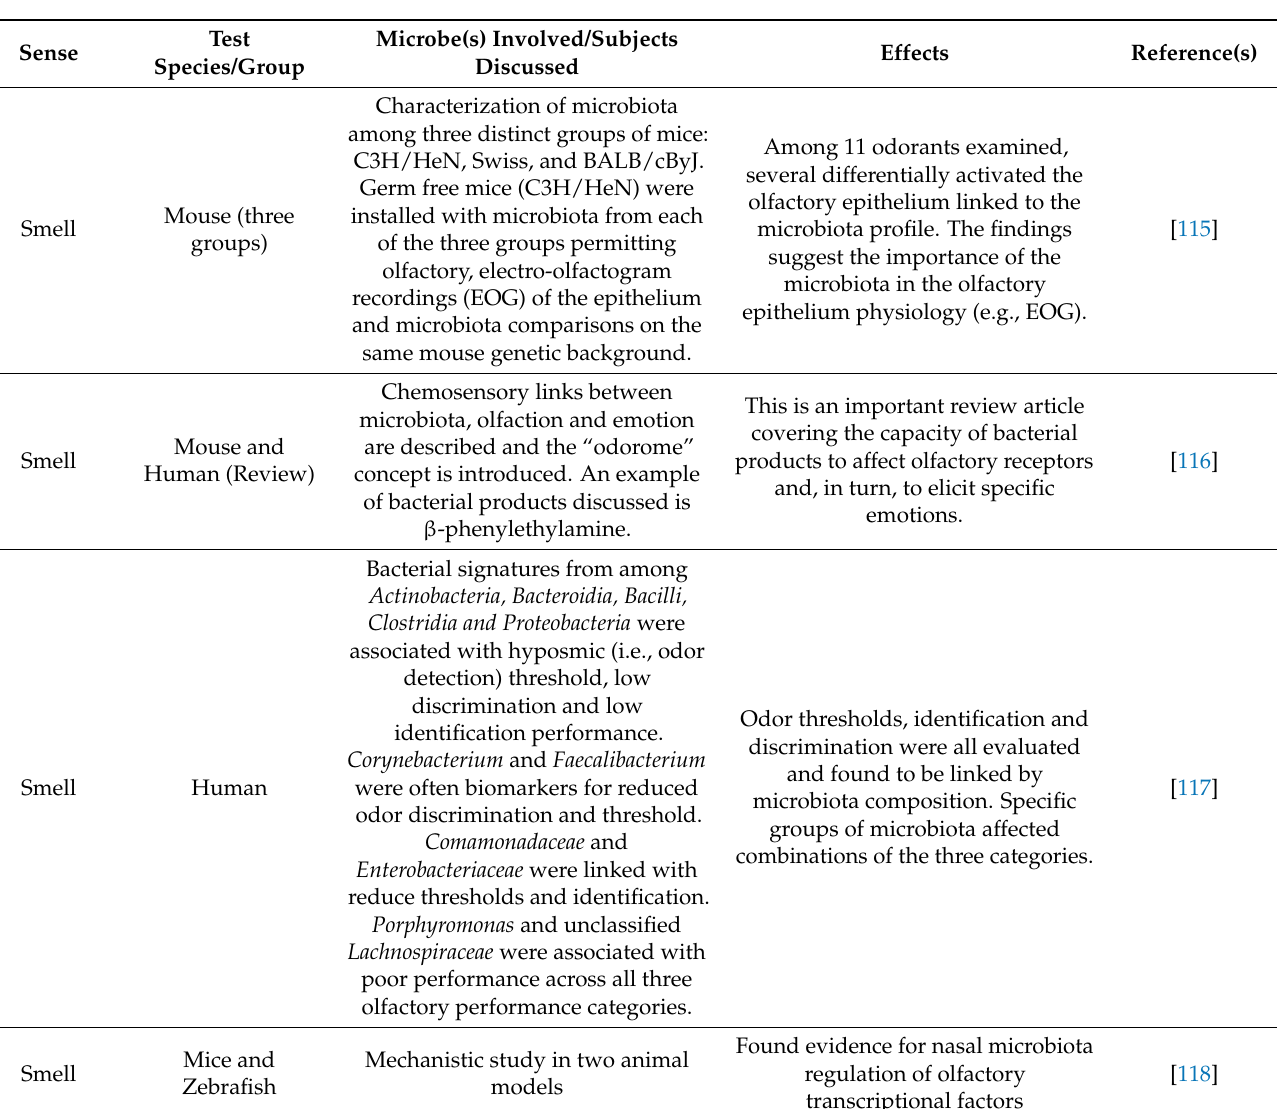
Table 3. The Role of Microbiota in